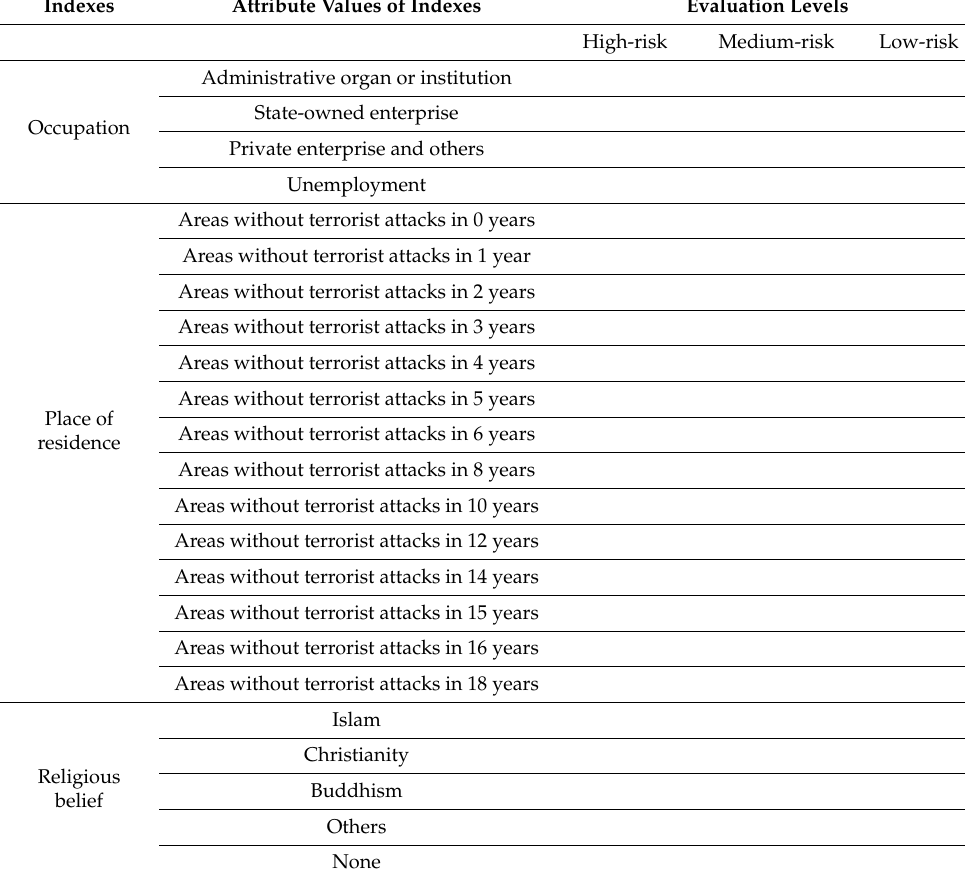
Table A8. Single factor evaluation of personal status